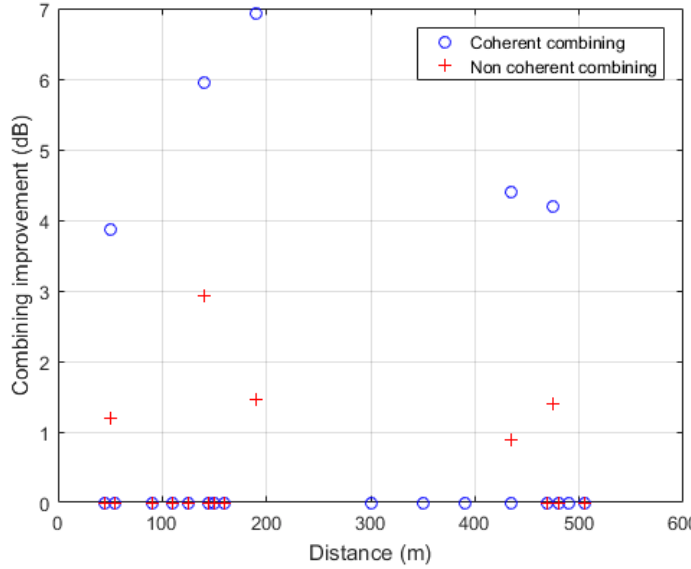
Figure 10. Combining improvement as a function of the distance.